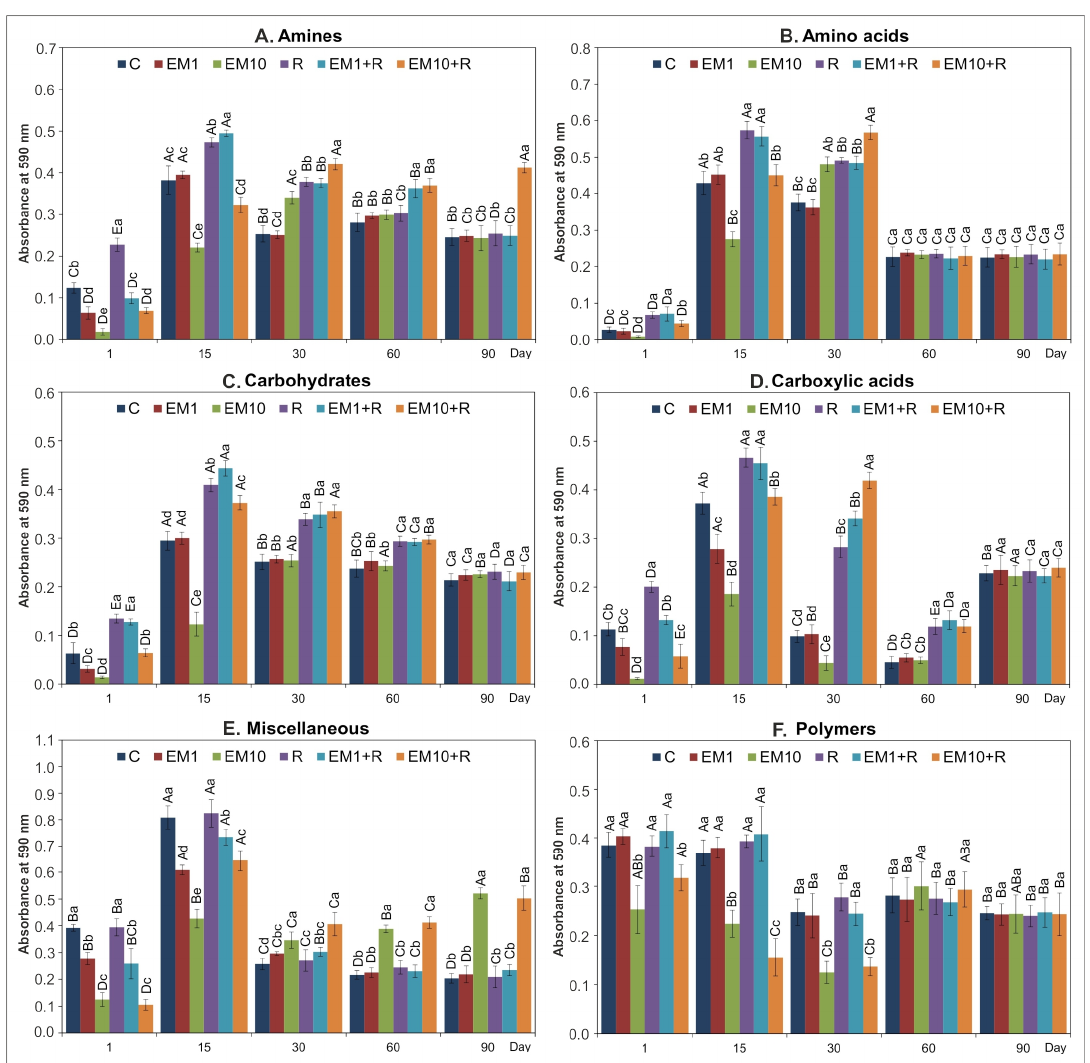
Figure 4. Effect of EM and/or strain MC3 on the AWCD values of carbon substrate groups, i.e., amines ( A ), amino acids ( B ), carbohydrates ( C ), carboxylic acids ( D ), miscellaneous ( E ) and polymers ( F ). The data presented are the means of three replicates with standard deviations. Significant di ff erences (LSD test, p < 0.05) between treatments at the same sampling time and between sampling times within the same treatments are denoted with di ff erent lower and uppercase letters, respectively. The treatment abbreviations are explained in Figure